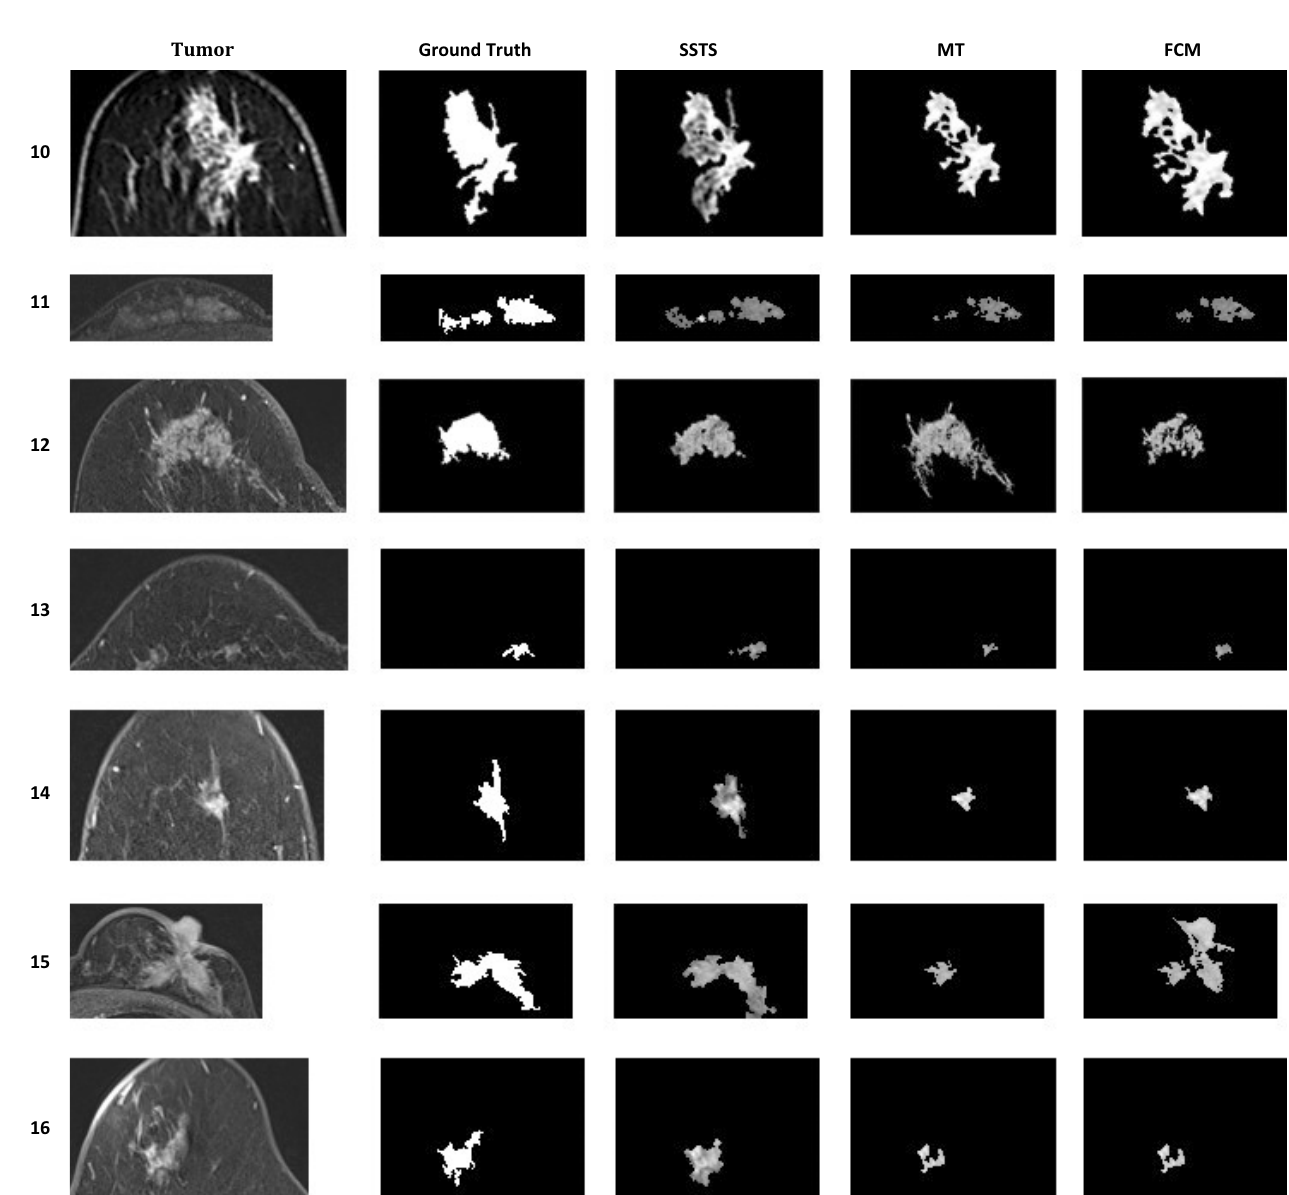
Fig. 9. Comparison of segmentation results of SSTS, MT, and FCM on nonmass tumors of seven